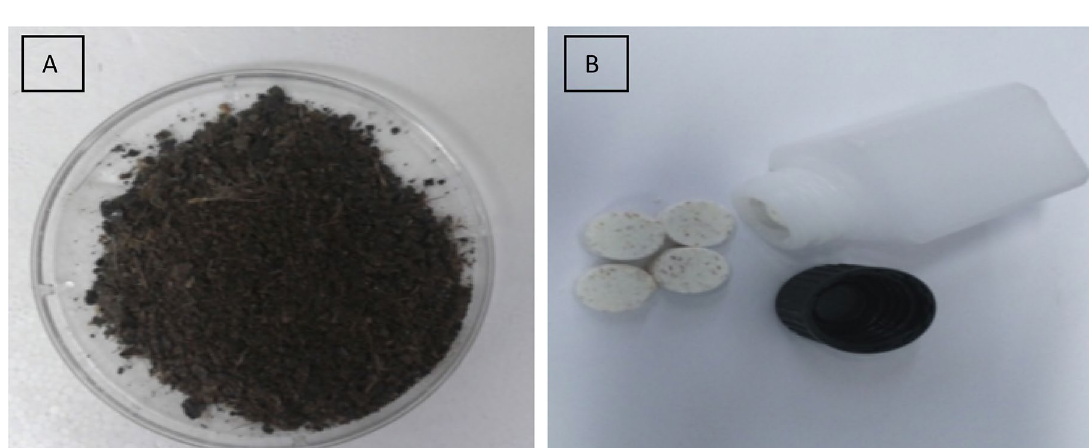
Figure 2. Final products: ( A ) Feather meal and ( B ) FPL